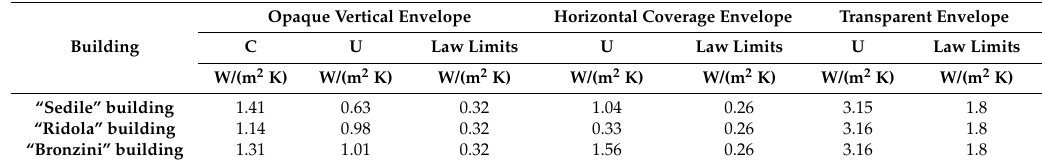
Table 3. Thermo-physical parameters of opaque envelope of case studies.